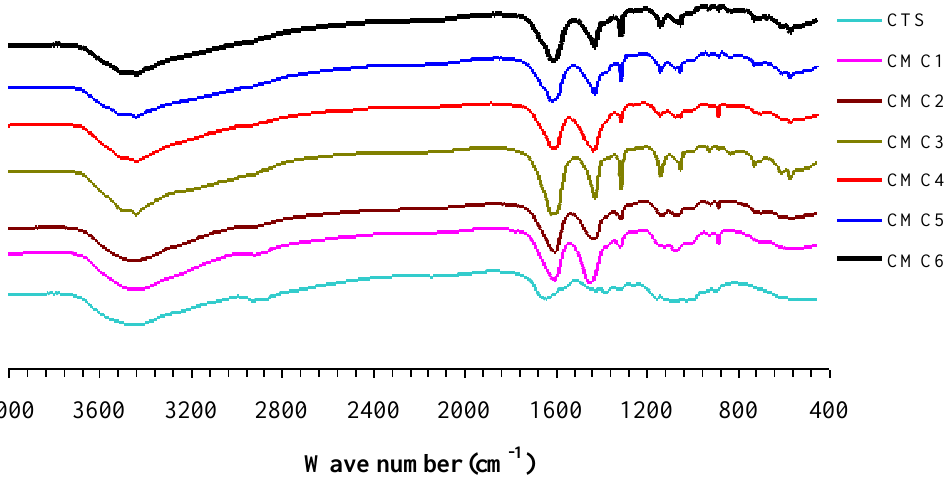
Figure 1. FT-IR spectra of native and modified